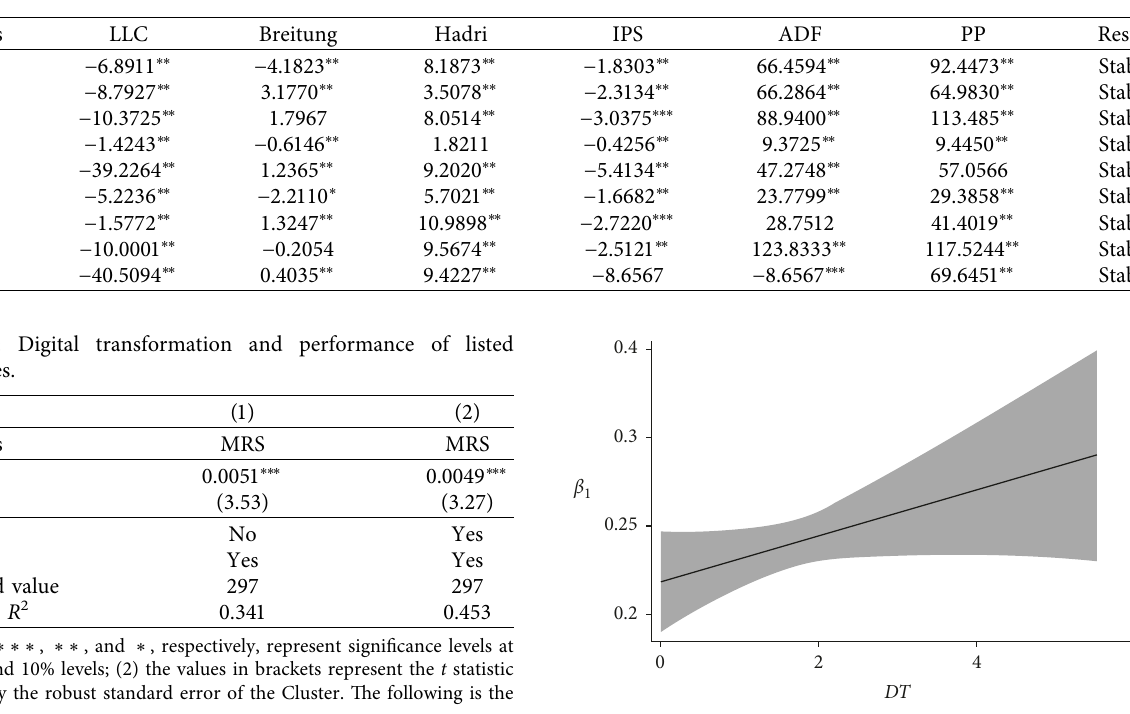
Table 3: Unit root test.